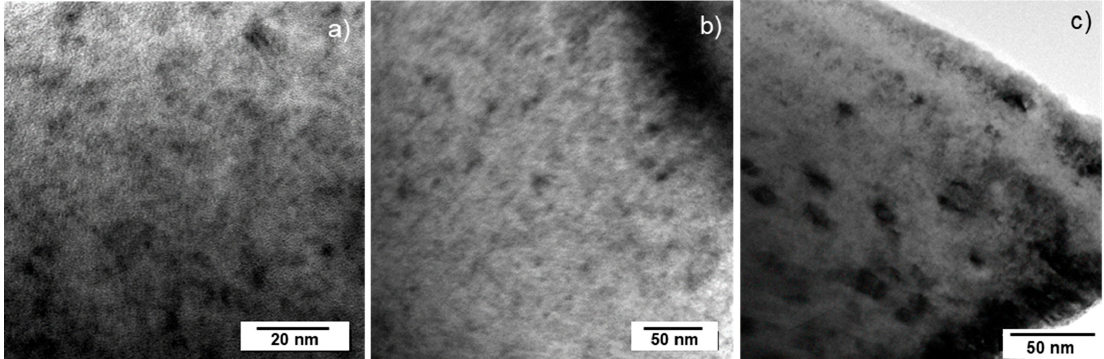
Figure 8. TEM bright field micrographs of sample UPuO-5 (0.34 dpa) showing ( a , b ) 3–7 nm dislocation loops ( c ) 20 nm dislocation loops.